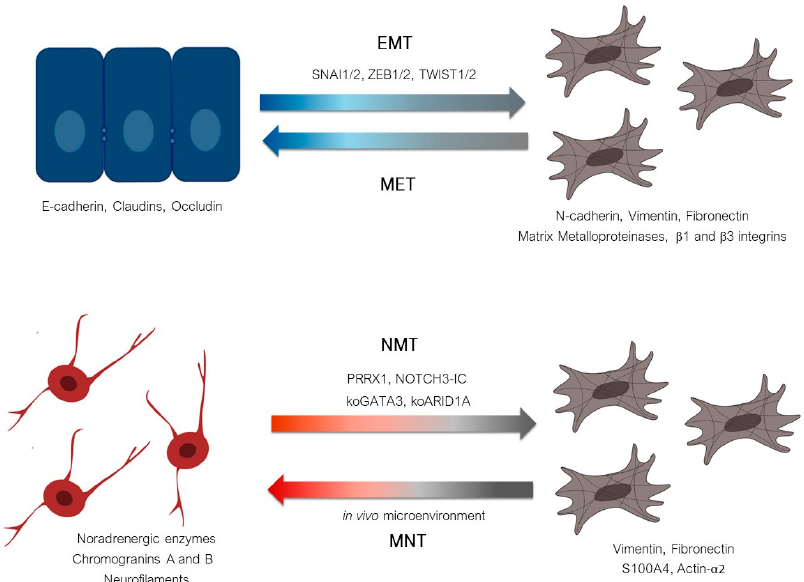
Figure 5. Plasticity from a noradrenergic to a mesenchymal identity in neuroblastoma defines a NOR-to-MES transition (NMT) reminiscent of the epithelial-to-mesenchymal transition (EMT). EMT, controlled by EMT effectors (SNAI1/2, ZEB1/2, TWIST1/2), refers to a shift from an epithelial cell expressing the emblematic marker E-cadherin to a cell expressing various mesenchymal markers. MET is known to be the reversion of EMT. NMT refers to the mechanism by which NOR cells transdifferentiate toward MES cells. Neuroblastoma NOR cells express typical neurofilament proteins and chromogranins as well as TH and DBH. MES neuroblastoma cells exhibit expression of typical